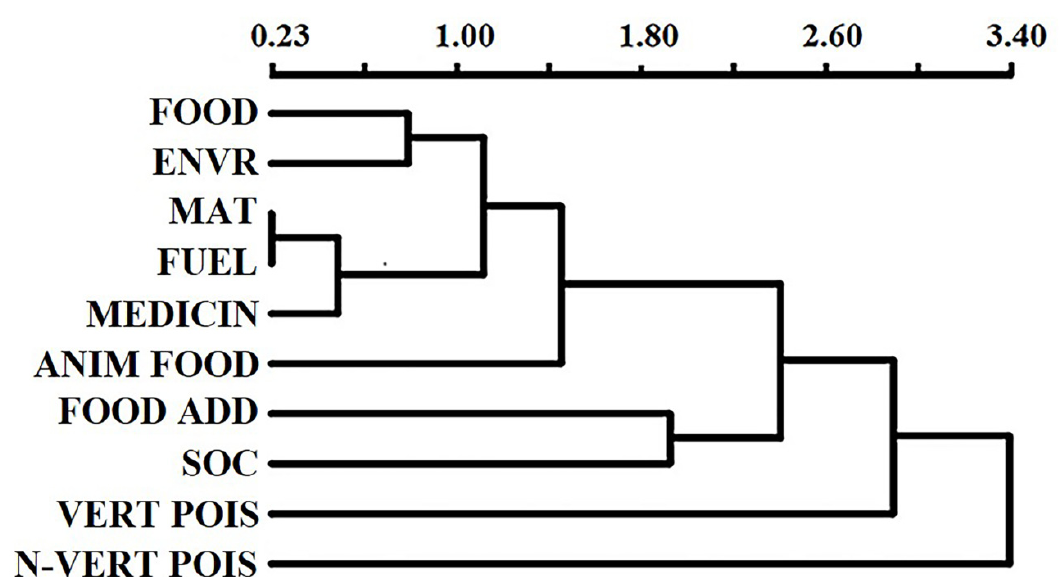
Figure 3. Dendrogram of Two-way Cluster Analysis comprising the species of the five subfamilies and 10 use categories (see Table S1 for definitions of Acronyms), correlation coefficient (r = 0.80279). The dendrogram is a graphical representation of its main matrix. The x -axis values are the measure of similarity or distance at which clusters join, re-ordered according to the order they were generated. Use categories stands for FOOD (Food for humans); ENVR (Environmental uses); MAT (Materials); FUEL (coal, firewood, and resins); MEDICIN (Medicines); ANIM FOOD (Animal food); FOOD ADD (Food additives); SOC (Social uses); VERT POIS (Vertebrate poison); N-VERT POIS (Non-vertebrate poison).